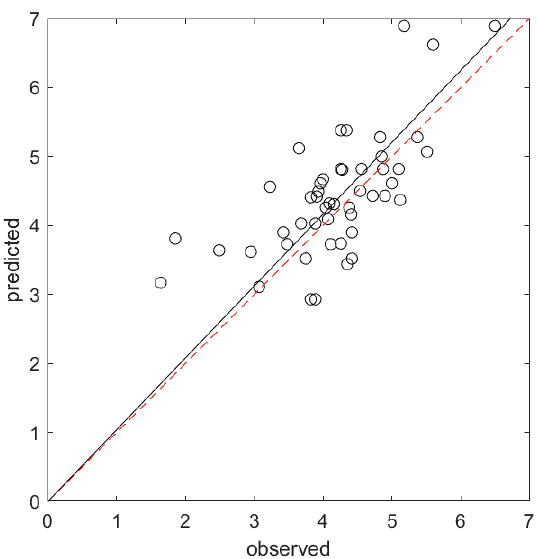
Figure 6. Peak significant wave height for independent storms, as recorded by six wave buoys (observed) and predicted by the numerical model. Red dashed line represents ideal agreement between the two data sets. Black line is the best fit with slope of 1.0409.